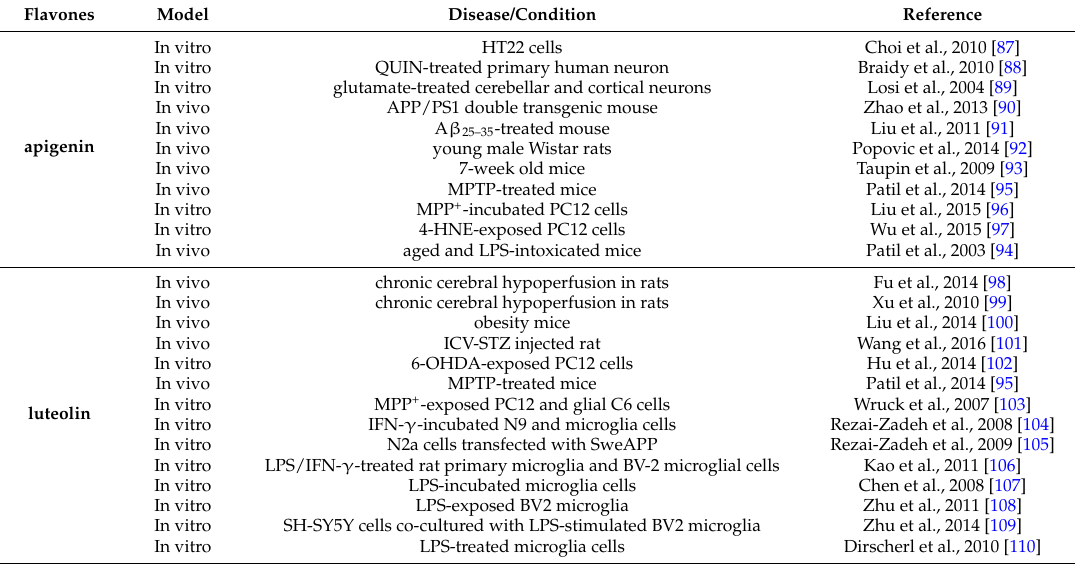
Table 2 reported the studies in which was evaluated apigenin as potential neuroprotective agent. Table 2. Studies employed the Citrus flavones and their experimental models of